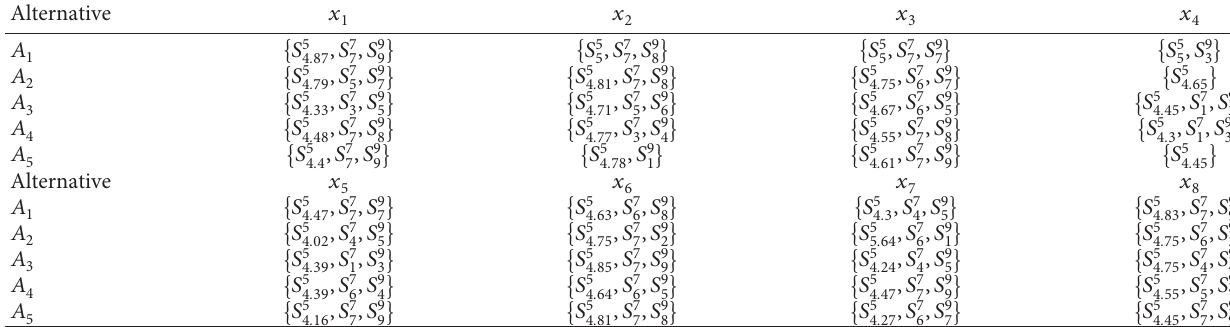
Table 4: The linguistic evaluation matrix.